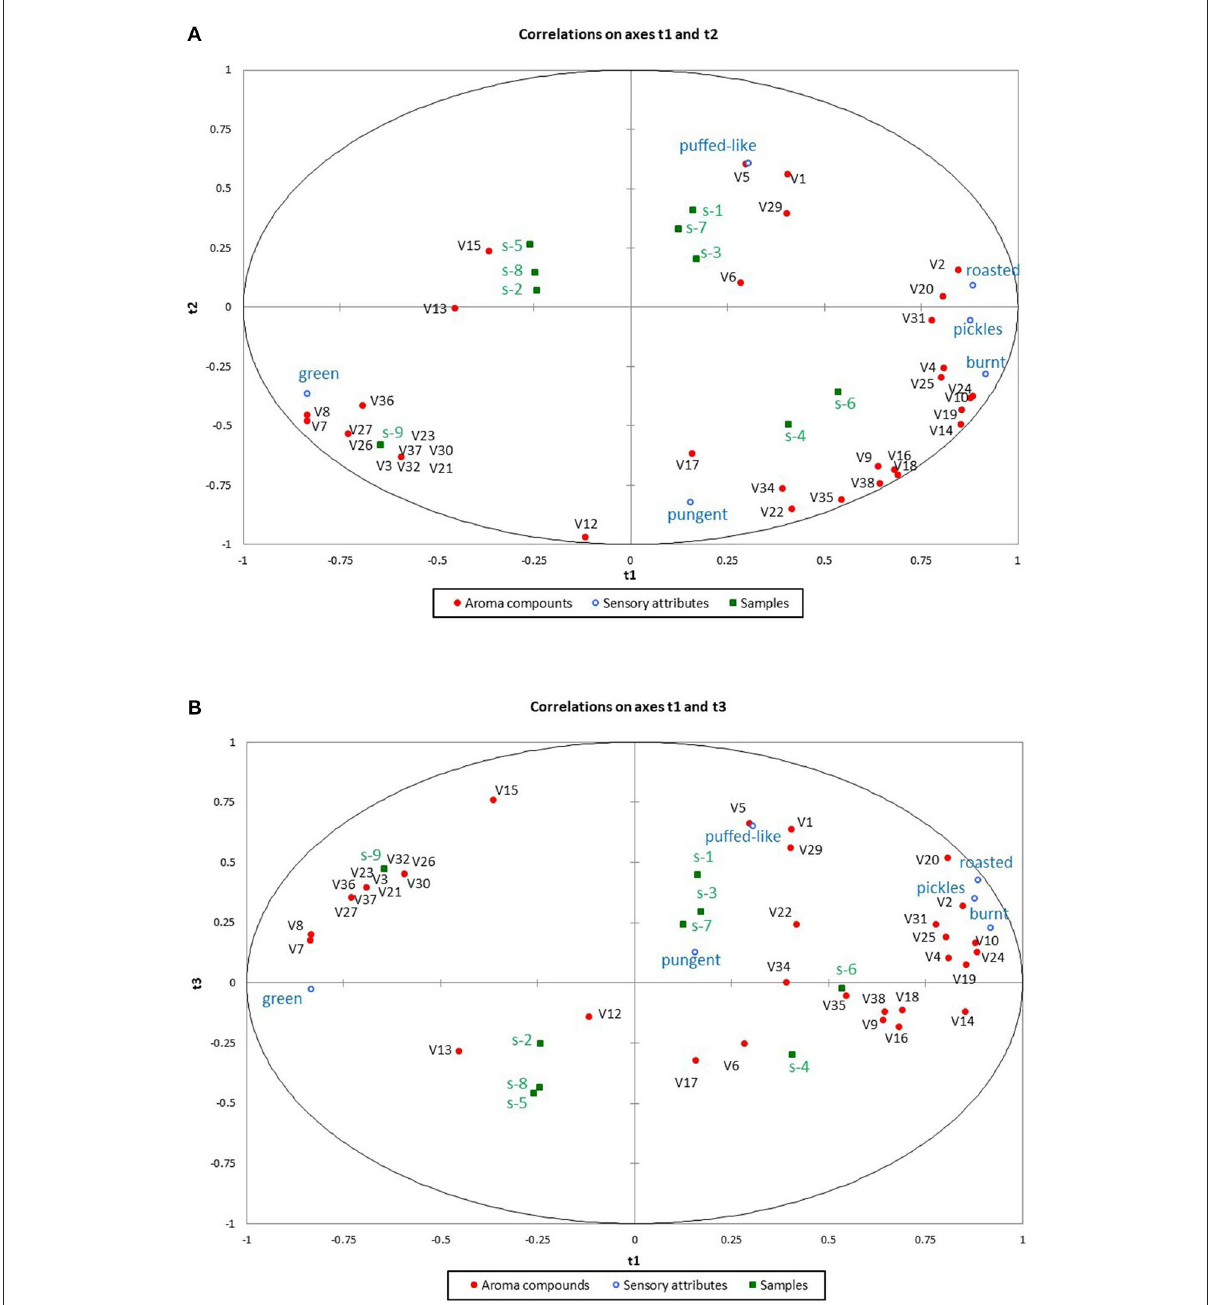
FIGURE4 Partial least squares correlation model analysis of aroma compounds and sensory characteristics (A) axes t1 and t2. (B) axes t1 and t3.